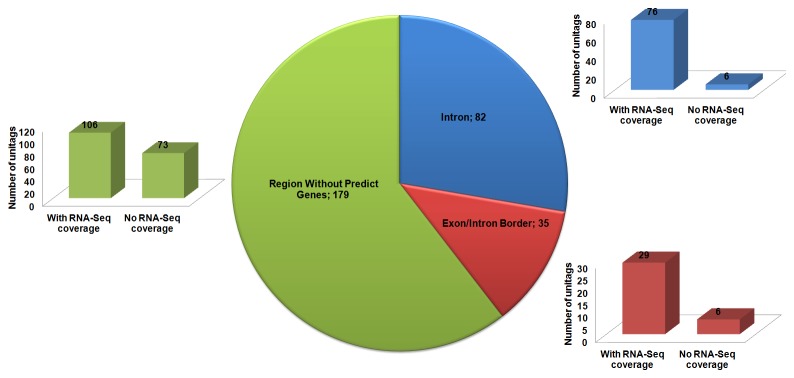
Number of unitags anchored in different soybean genomic regions*, with or without the coverage of RNA-Seq data*.* According to the soybean genome browser (Phytozome database: http://www.phytozome.net/).